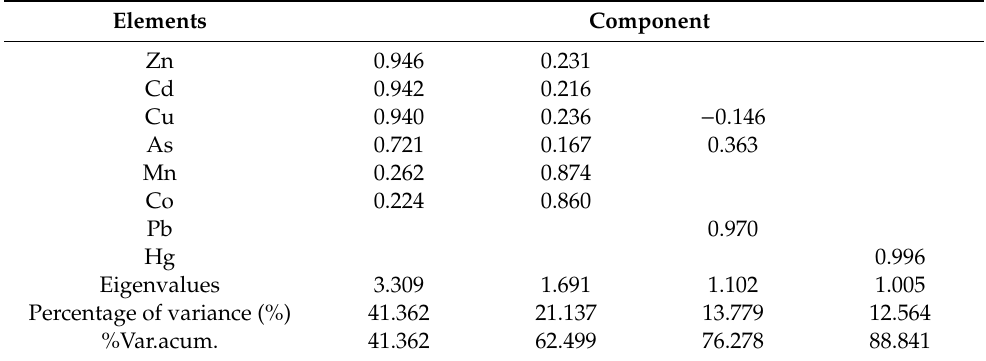
Table 6. Rotated component matrix for PTEs in